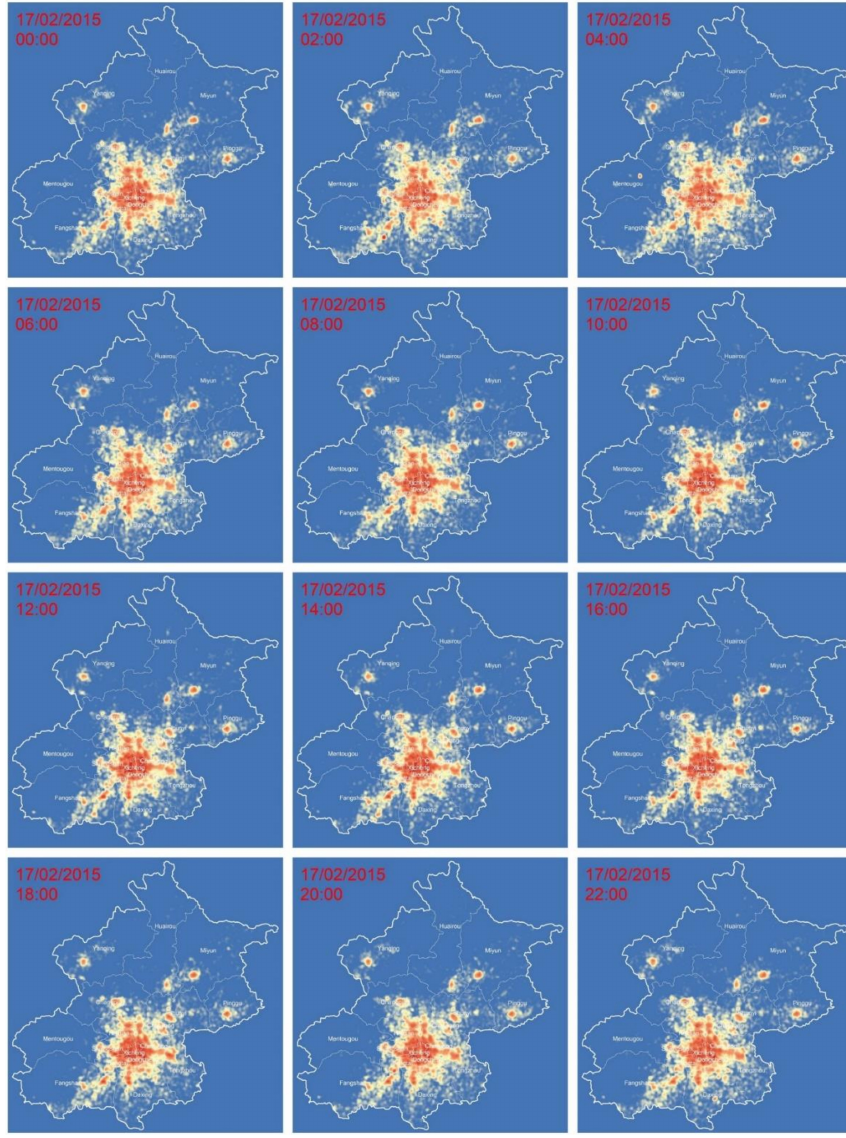
Figure 15. Estimated population density distribution in Beijing on 17 / 2 /